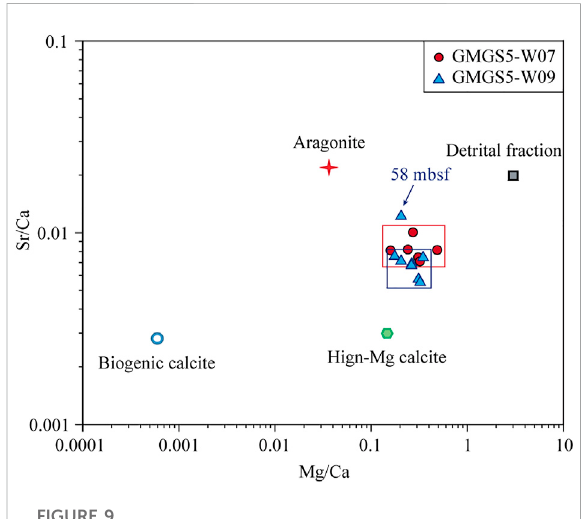
FIGURE 9 Sr/Ca ratios vs. Ma/Ca ratios of the sediment samples. The end-memberratiosofaragonite,high-Mgcalcite,biogeniccalcite, and the detrital fraction from Yang et al. (2014) were